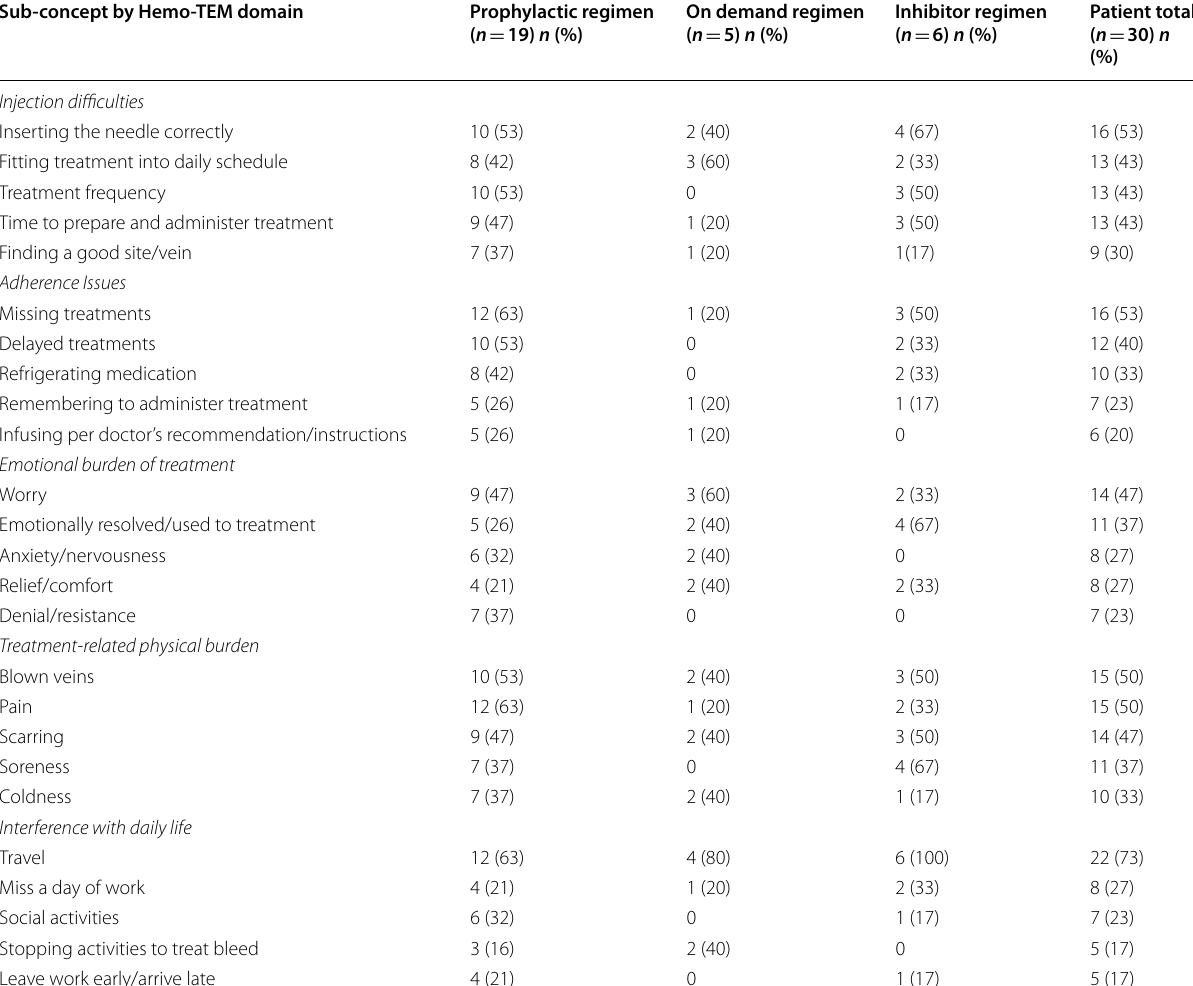
Table 3 Top sub-concepts by Hemo-TEM domain Sub-concept by Hemo-TEM